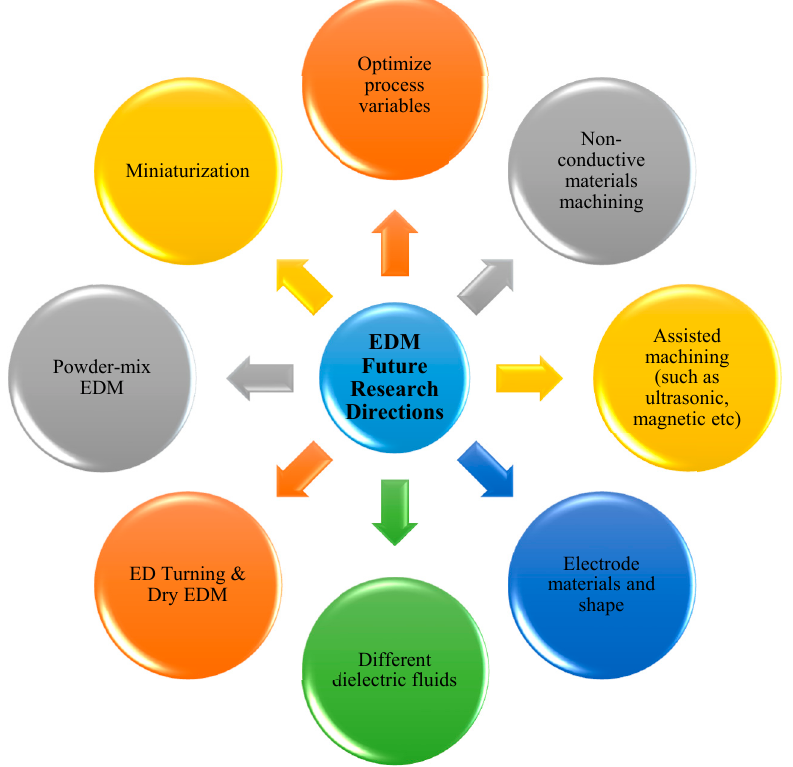
Figure 17. Future research areas in the EDM field.